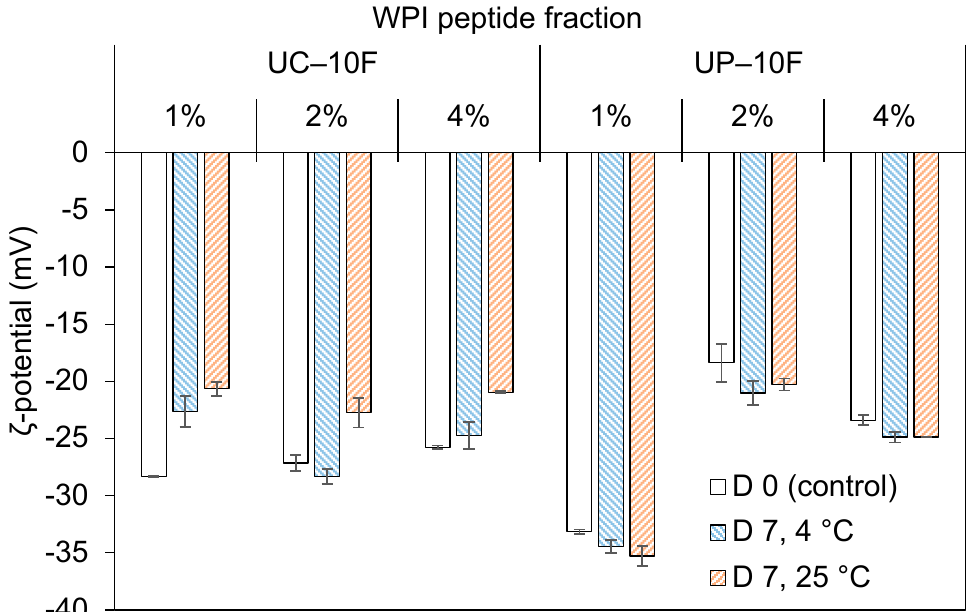
Figure 4. ζ -potential of nanoemulsions or emulsions formed with 1%, 2%, and 4% UC–10F chymotrypsin and UP–10F pepsin WPI fractions on D 0 (control) and 7. Samples were stored at 4°C or 25 °C. Table 3. Creaming (%) in UC–10F WPI fraction nanoemulsions at 1 and 2% peptide concentrations. Storage Time